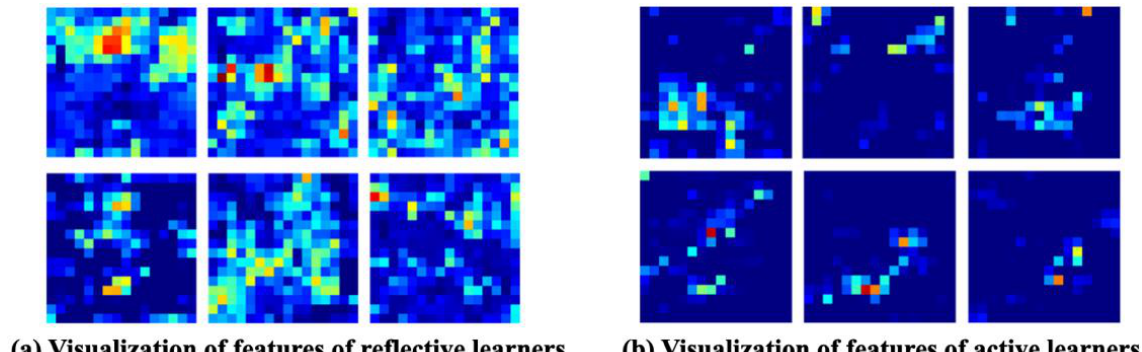
Figure 9. Visualization of features of the learners’ learning styles.